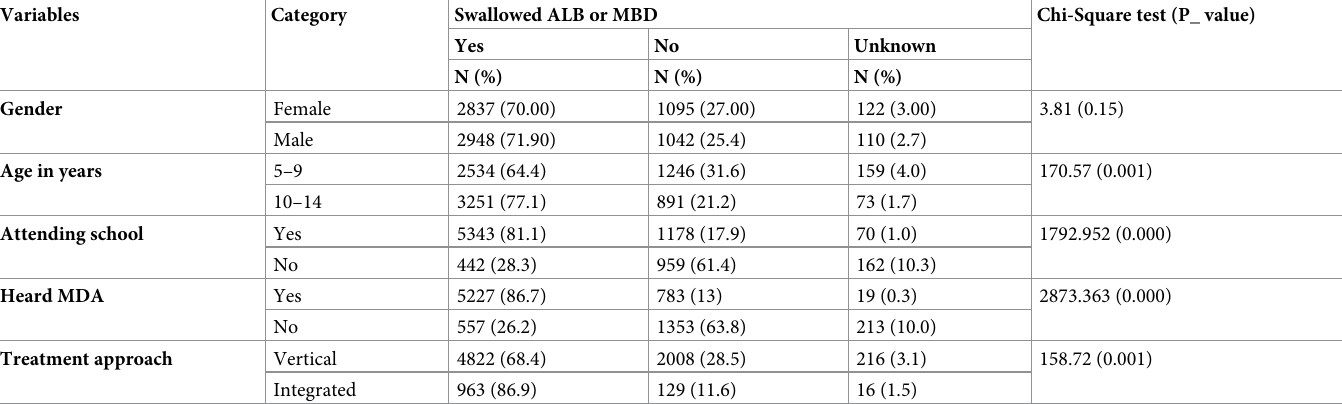
Table 3. Difference in proportion of swallowing ALB or MBD in relation to different factors in Ethiopia (N = 8154). Variables